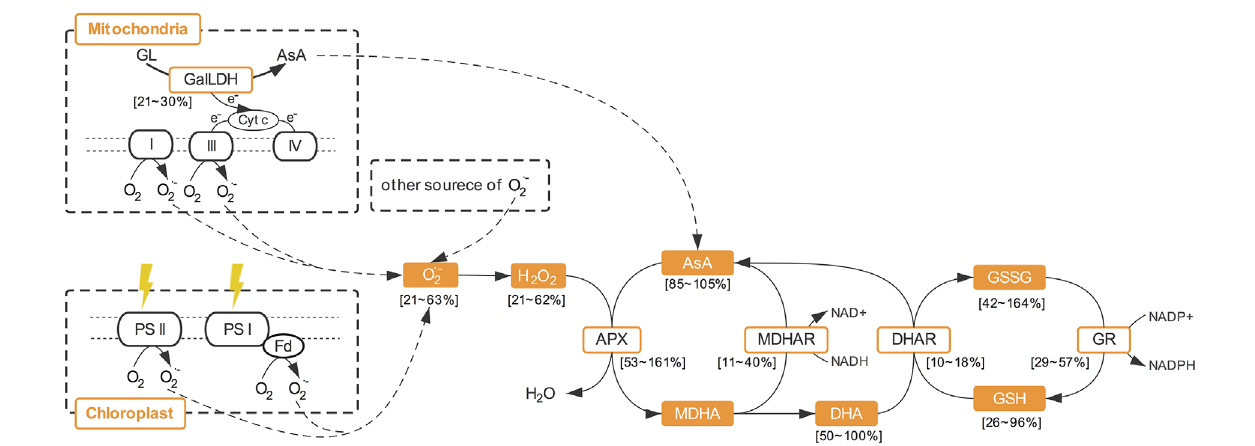
FIgURe 8 | The roles of ascorbate metabolism in ROS scavenging. AsA, ascorbate; APX, ascorbate peroxidase; DHA, dehydroascorbate; DHAR dehydroascorbate reductase; GalLDH, L-galactono-1,4- lactone dehydrogenase; GR, glutathione reductase; GSH, glutathione; GSSG, oxidized glutathione; MDHA, monodehydroascorbate; MDHAR, monodehydroascorbate reductase; T-AsA, total ascorbate; T-GSH, total glutathione.